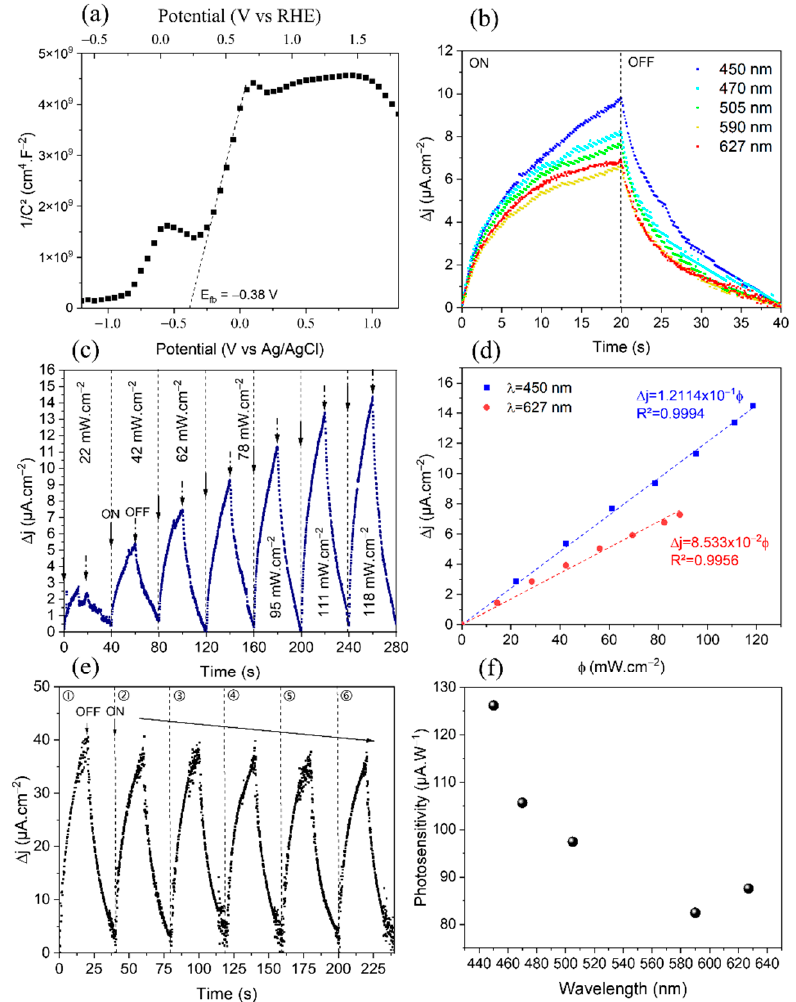
Figure 7. ( a ) Mott–Schottky plot. ( b ) Transient photocurrent response under illumination and dark conditions of BFO thin film for various wavelengths ranging from 450 to 627 nm ( ϕ = 62 mW/cm 2 ). ( c ) Transient photocurrent response (On–Off cycles every 20 s) as a function of the incident light intensity ( λ = 450 nm, and V = 0.6 V vs. Ag/AgCl). ( d ) The evolution of Δ j ( ϕ ) for λ = 450 and 627 nm and the fit in dashed lines. ( e ) Transient photocurrent response registered for six cycles ON/OFF (every 20 s) and under constant solar simulator of 100 mW/cm². ( f ) Photosensitivity of BFO thin film sample as a function of wavelength.